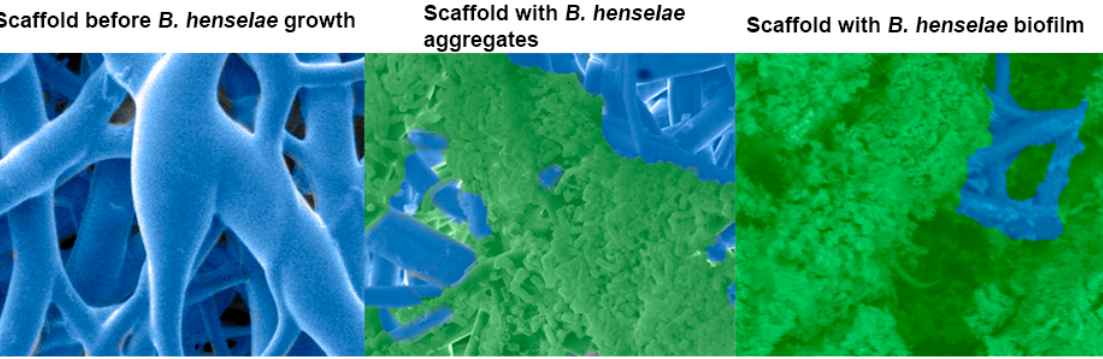
Figure 1. Scanning electron micrograph of a 48 h Bartonella henselae ( B. henselae ) biofilm growing on a 3-dimensional nanofibrous scaffold. Left, scaffold before bacterial growth. Middle, bacterial growth, adhesion, and aggregation around the scaffold branches. Right, B. henselae biofilm covering the scaffold and eclipsing the bacterial cells. Biofilm was preserved by the addition of the cationic dye, Alcian